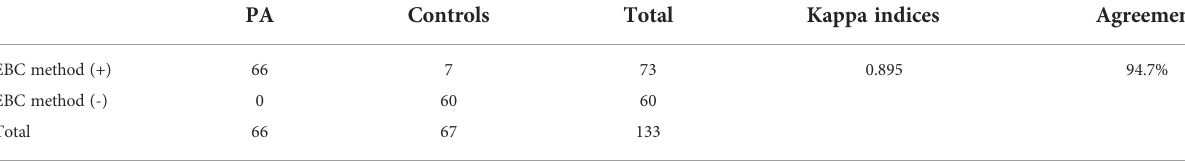
TABLE 4 Performance of EBC method in the diagnosis of PA. PA Controls Total Kappa indices Agreement